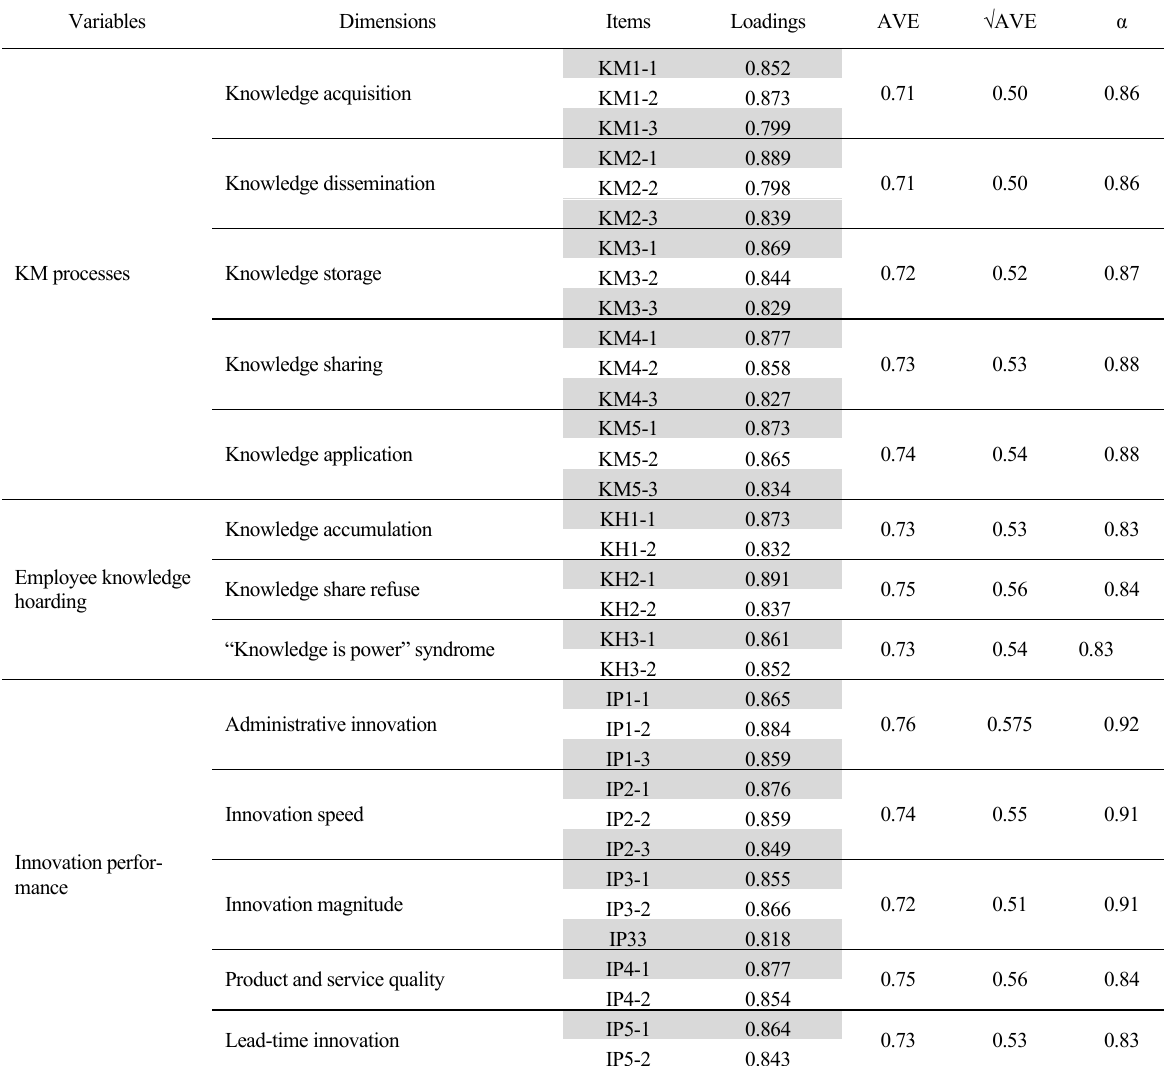
Results of validity and reliability tests